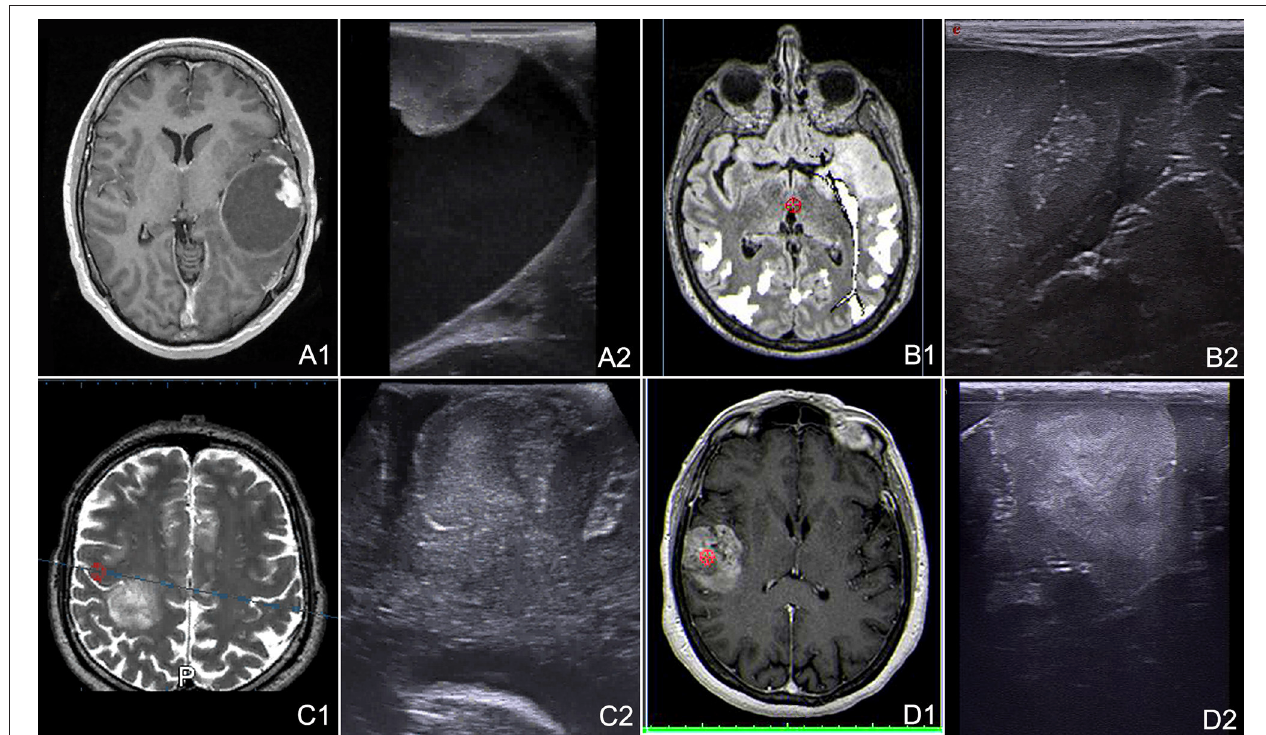
FIGURE 1 | B-mode representation of different glioma grades. (A) Left temporal pilocytic astrocytoma. (B) Left temporal diffuse astrocytoma. (C) Right parietal anaplastic astrocytoma. (D) Right temporo-parietal glioblastoma. (1) pre-operative volumetric MRI. (2) Intra-operative trans-dural US scan. Note the different lesion appearances and in particular the different degree of margins